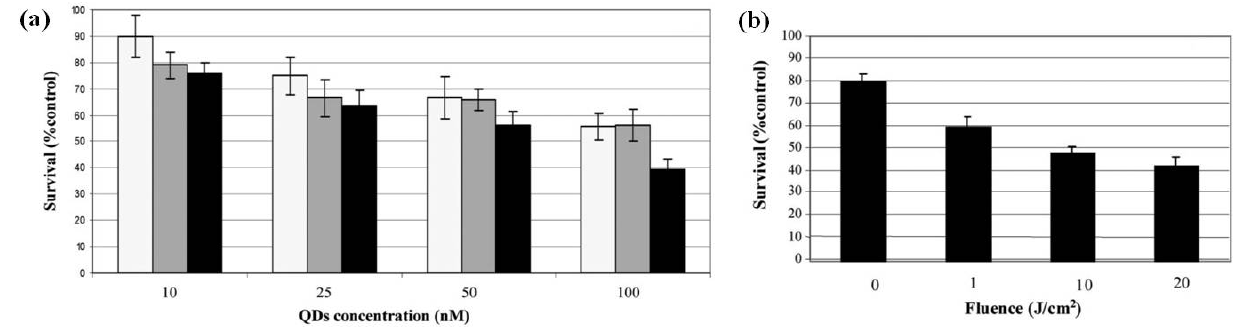
Figure 7. ( a ) Measurement of PDT sensitivity of KB cells treated with FA-conjugated QD 4 . Cells were exposed to QDs in a concentration range of 10–100 nM for 1 (light gray), 3 (dark grey) and 6 h (black); ( b ) Survival curves obtained for cells incubated with QDs at 5 nM for 3 h incubation before irradiation to increasing doses of light from 1 to 20 J cm − 2 . Measurement of PDT sensitivity for the QDs were obtained by MTT test (data points show the mean ± s.d., n = 6). * P < 0.05 vs. previous fluence dose. Reprinted